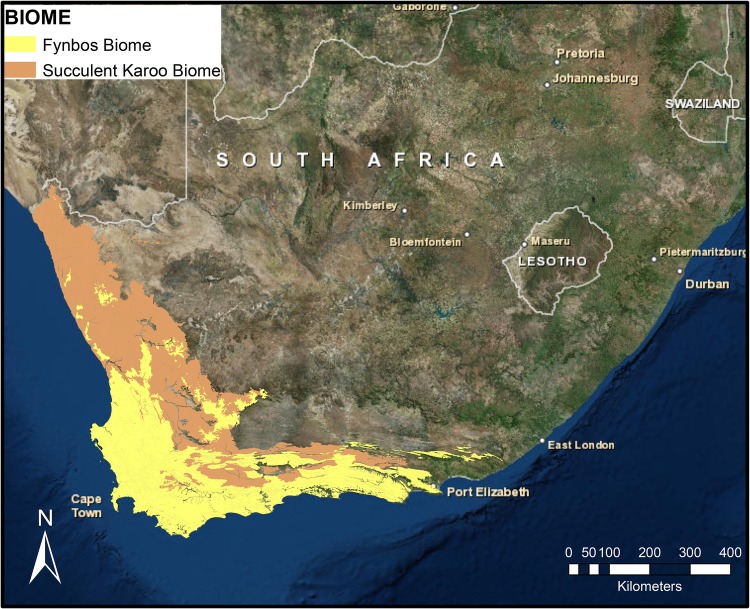
Map of the GCFR showing the Fynbos and the Succulent Karoo Biomes constructed based on Mucina and Rutherford (2006).